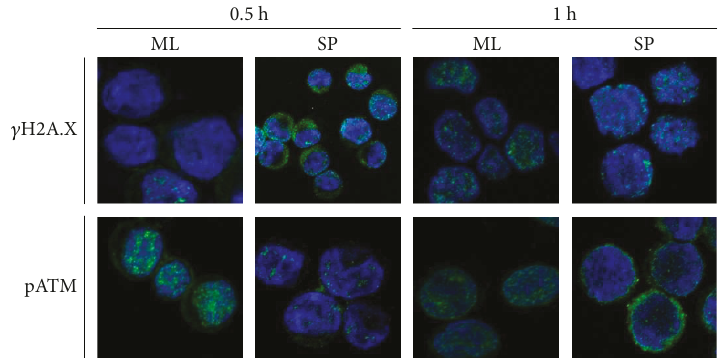
Figure 5: HeLa SP overexpress pATM and γ H2A.X after ionizing radiation. Localization of pATM and γ H2A.X expression after 0.5 h and 1h exposure to ionizing radiation in HeLa SP and HeLa ML using anti-pATM antibody (green) and anti- γ H2A.X antibody (green). Visualization of nuclei by DAPI (blue). The representative images of the microscopy analysis indicated that γ H2A.X is activated always in SP cultures, while in ML cultures, the activation of γ H2A.X began 1h after exposure to 1.5Gy IR dose. Objective